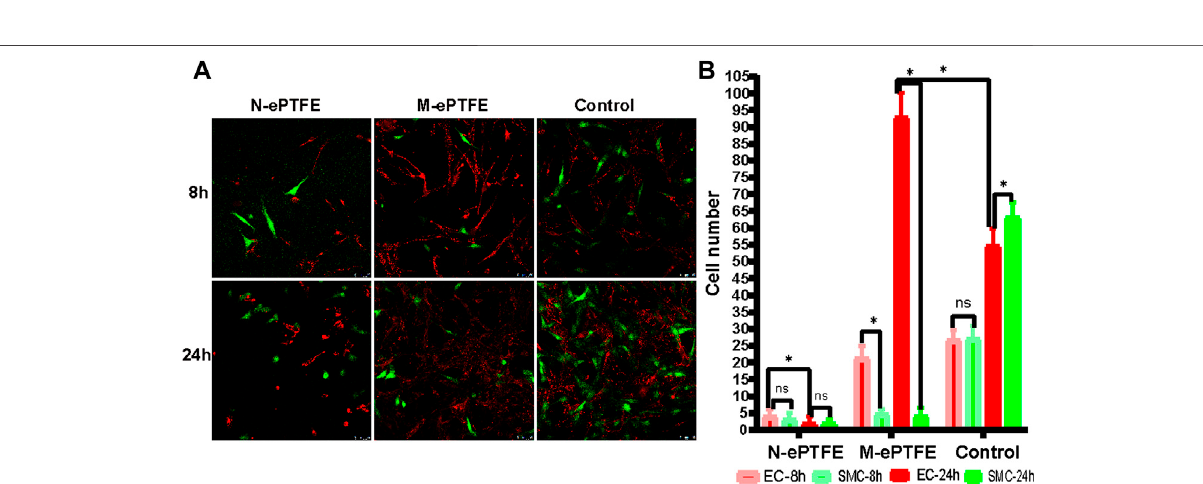
Frontiers in Bioengineering and Biotechnology |